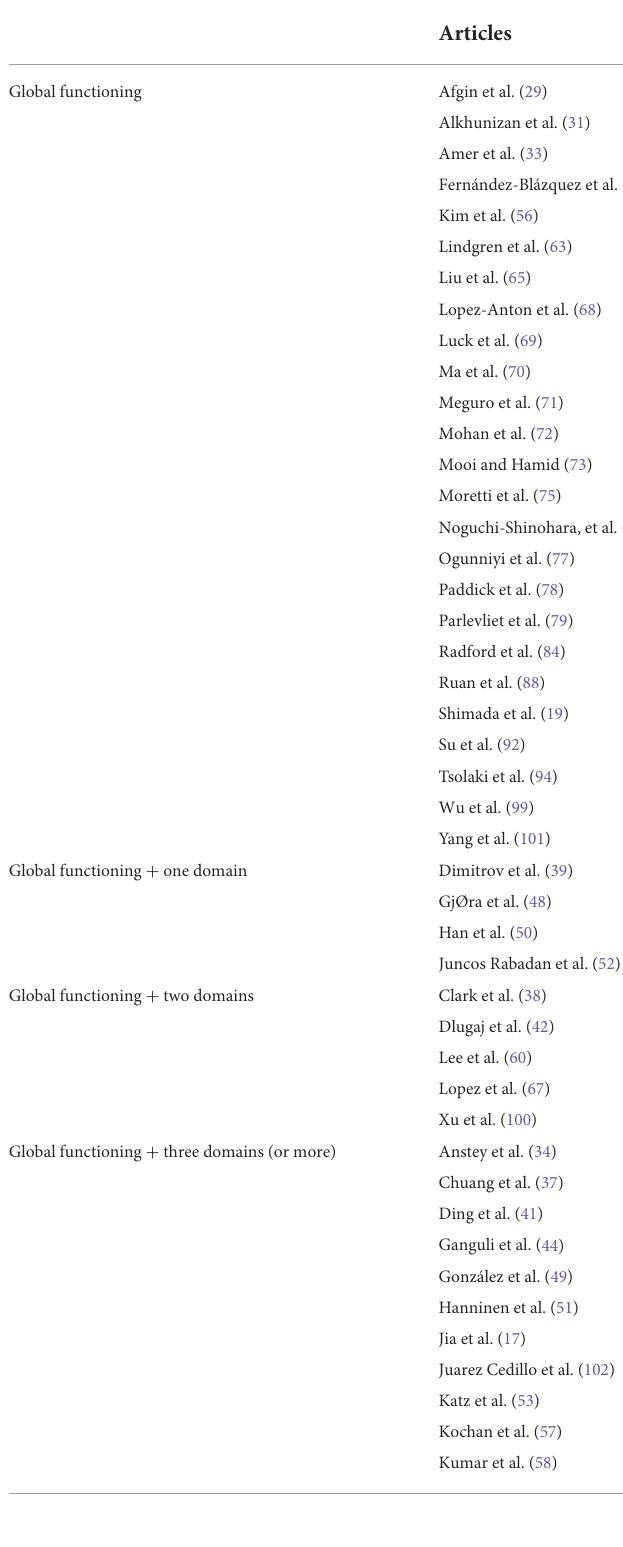
TABLE 6 Prevalence range according to the assessed cognitive domains a